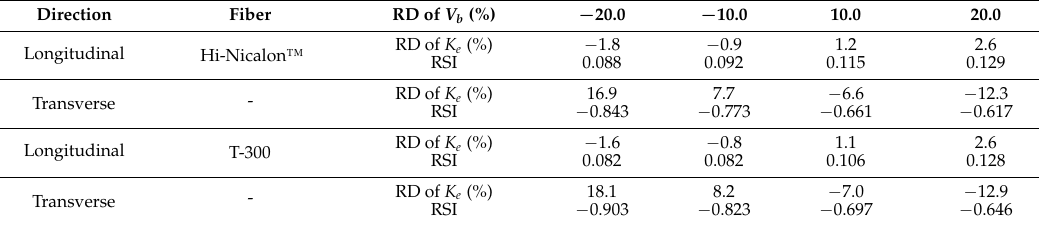
Table 11. Sensitivity analysis of Bundle volume fraction for 2D composites.